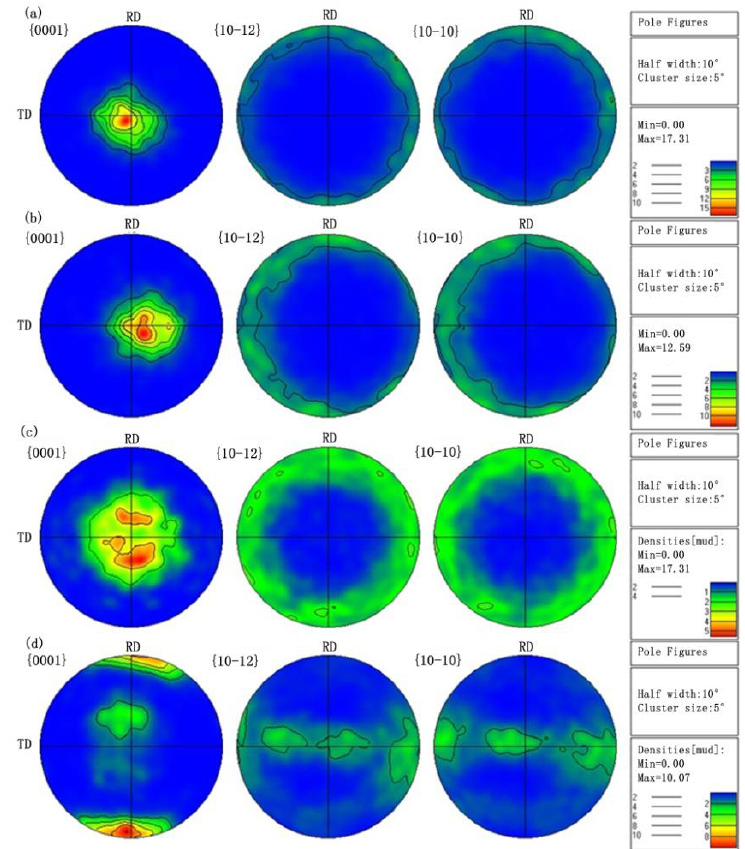
Figure 5. The pole figures of AZ31B magnesium alloy under cycles: ( a ) Base material; ( b ) Point ‘B’ in Figure 2b; ( c ) Point ‘C’ in Figure 2b; ( d ) Point ‘D’ in Figure 2b.